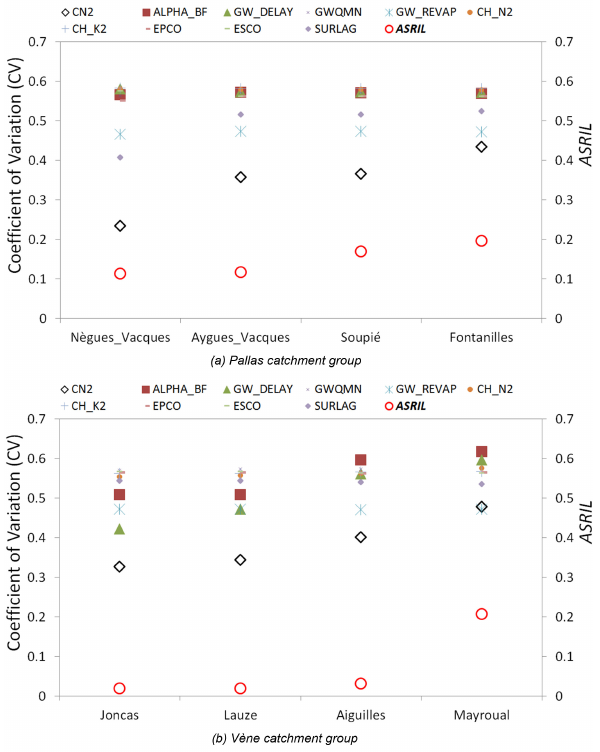
Table 6. Statistical criteria of the regionalization approach